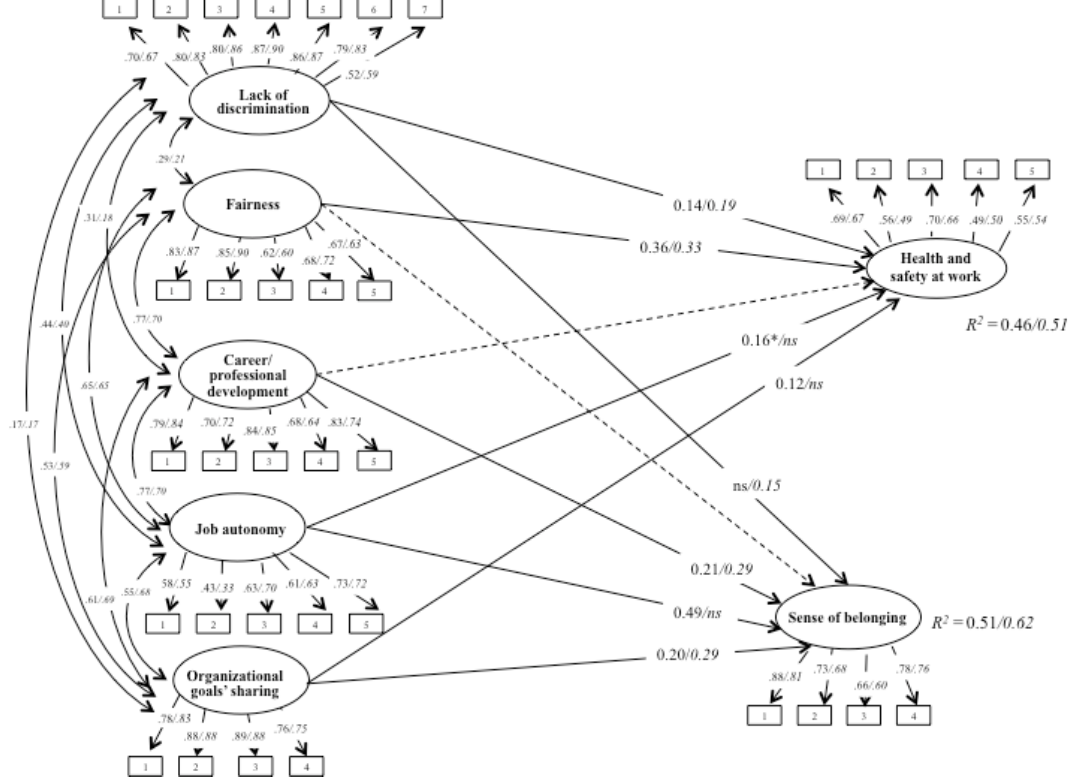
Figure 2. The structural equation model, standardized path coefficients ( p < 0.01, * p < 0.05). Results of the multi-group analysis: Clinical staff/non-clinical staff. Discontinuous lines indicate a non-significant relationship.